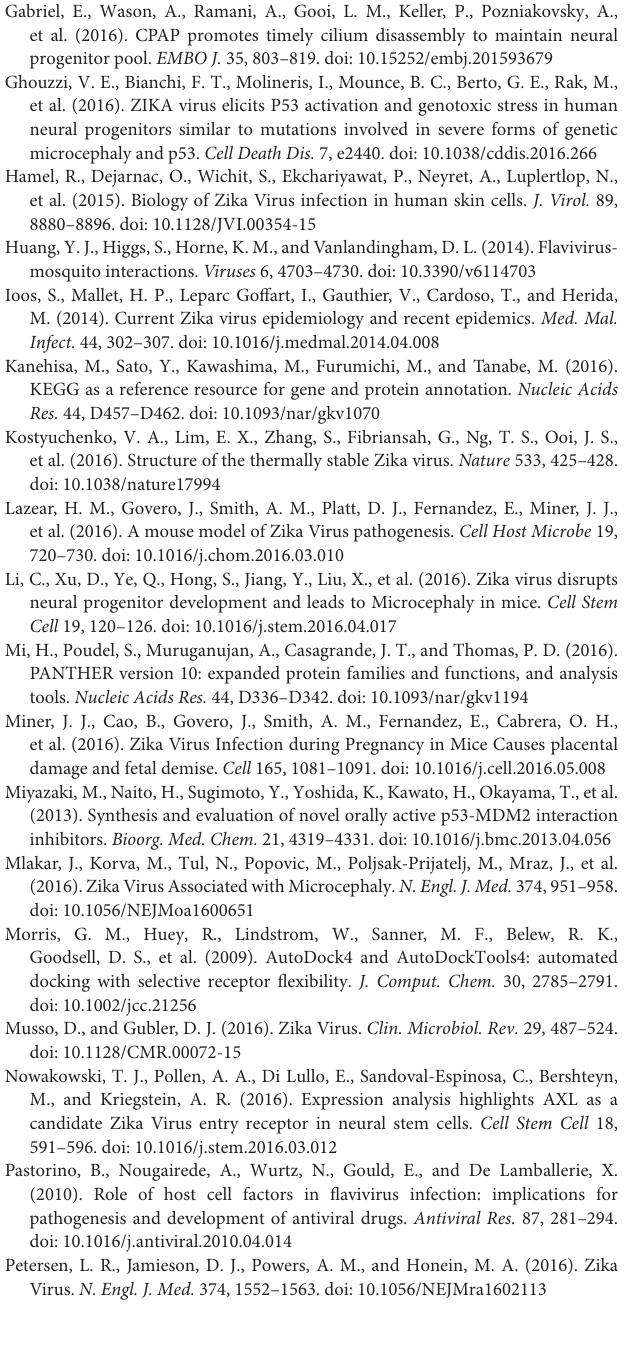
Figure S8 | Histopathological examination of mouse brain tissues at 6 h after injection. Hematoxylin and eosin staining of brain tissues from blank control mice (A,B) , control mice injected non-specific peptide (C,D) and mice injected with mimic peptide of the ZCP protein (E,F) . Bars: 100 µ m. Table S1 | ZIKV-related proteins in the human genome. Table S2 | Microcephaly-associated proteins in the human